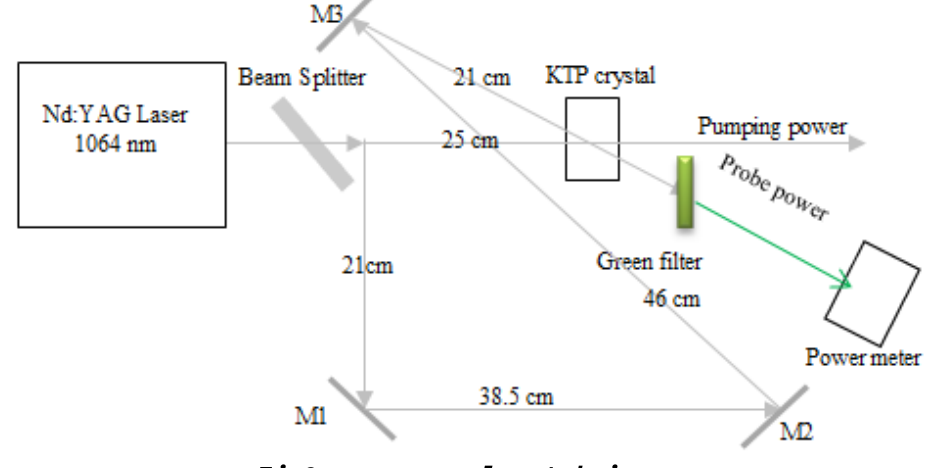
Fig.2: pump-power laser technique.